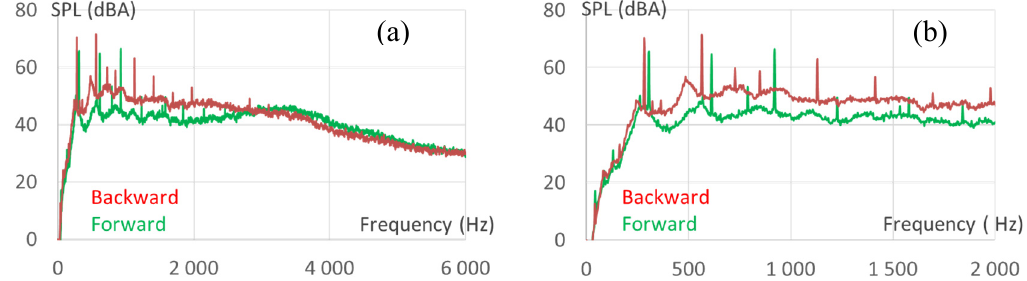
Figure 9. Compared acoustic spectra: ( a ) low to high frequencies, and ( b ) low to medium frequencies.